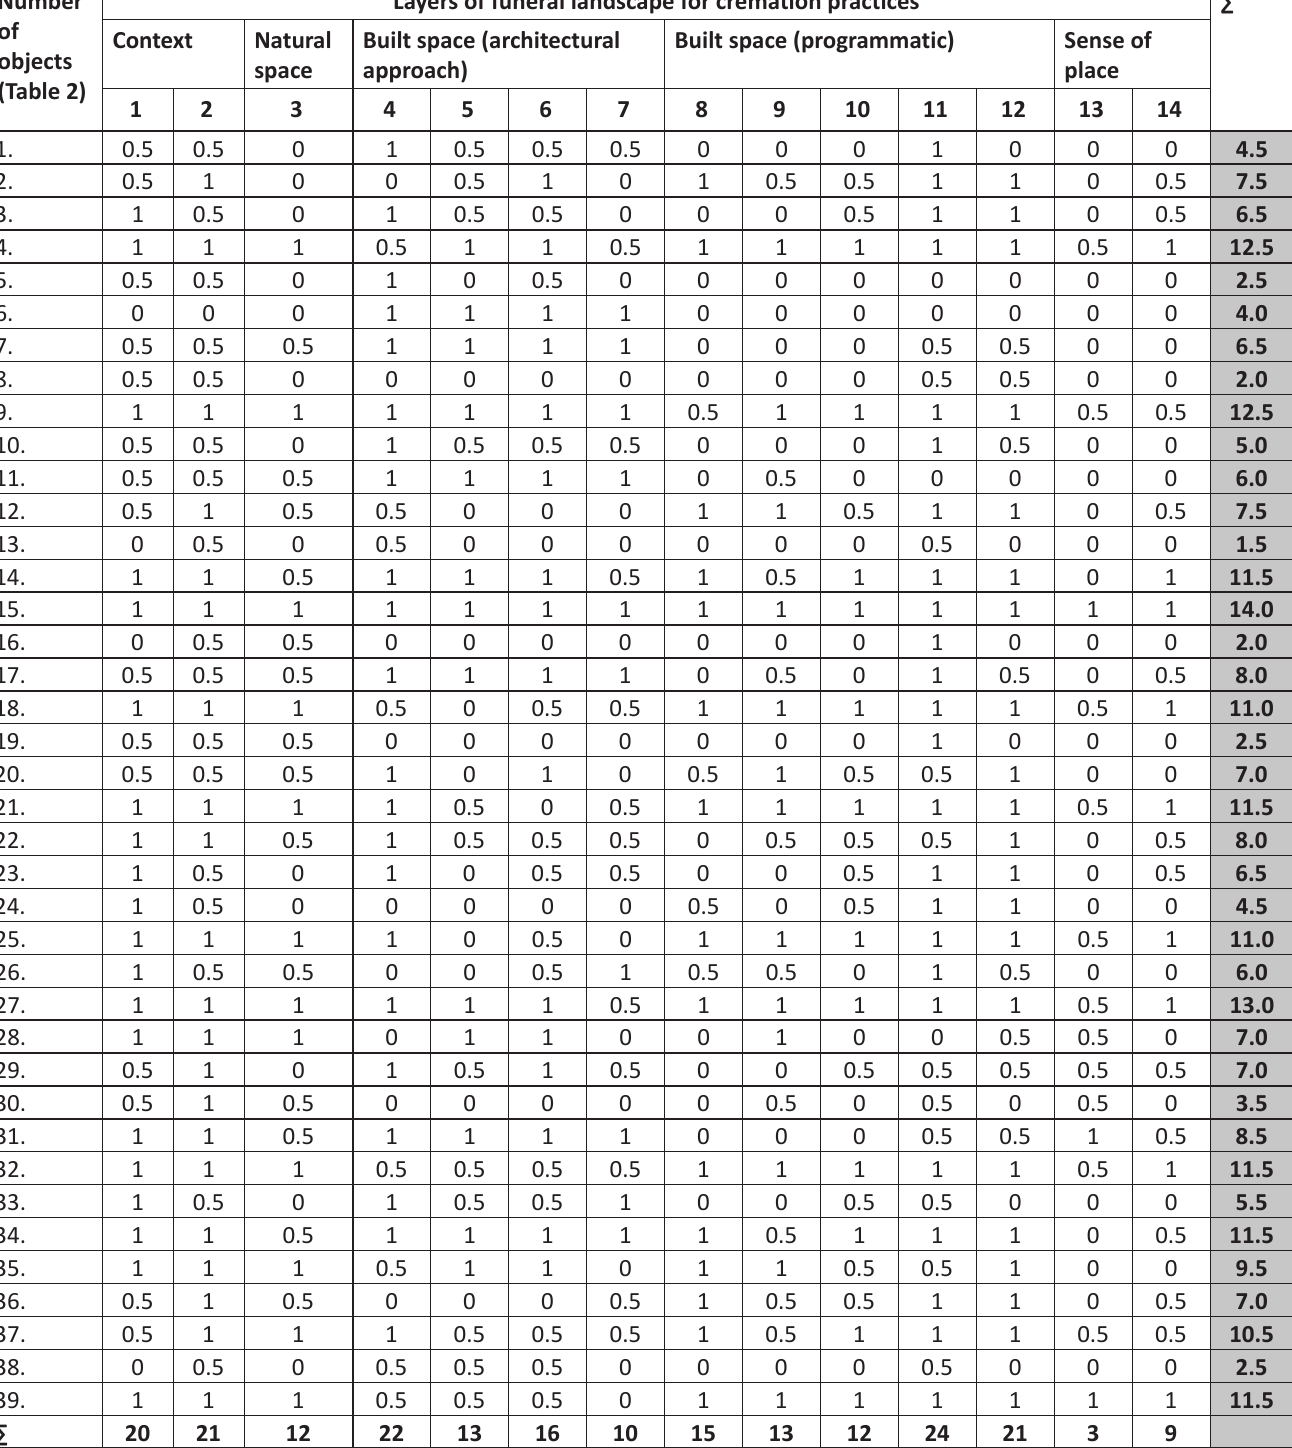
Table 6. Verification of design solutions in the selected contemporary funeral places in Poland (crematoria located in/next to existing cemeteries), where each sub-criterion (design solution) has been evaluated by using the scores of 1 (presence), 0.5 (moderate presence), and 0 (absence). Own